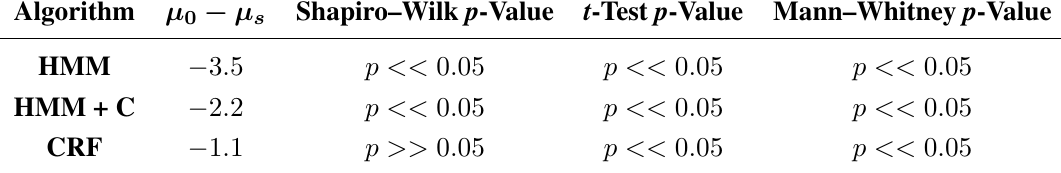
Table 7. Resulting p -values of the statistical tests ( µ µ : mean accuracy with silhouette subclassing). s